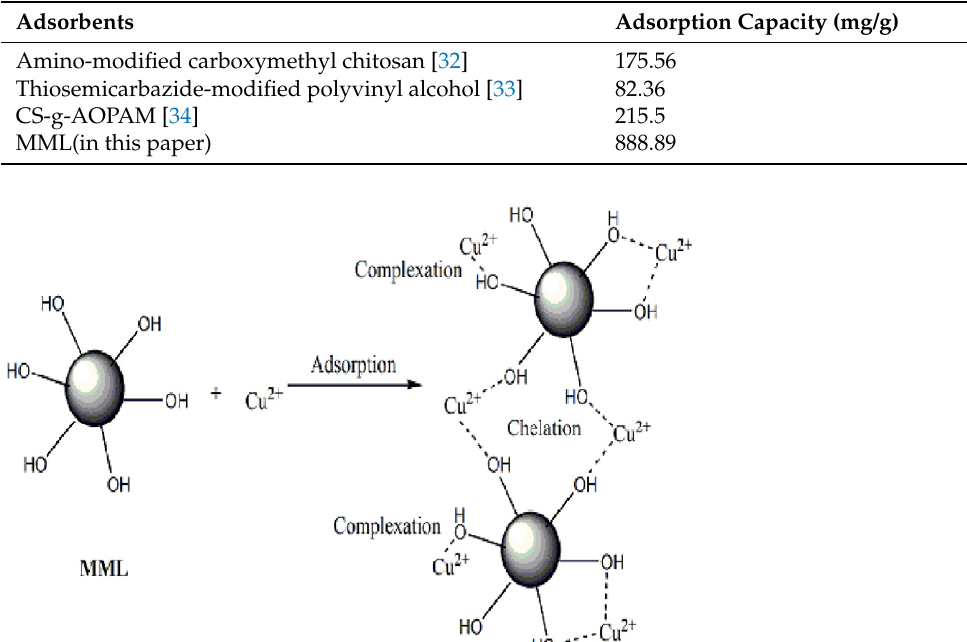
Table 4. Reuse of MML.